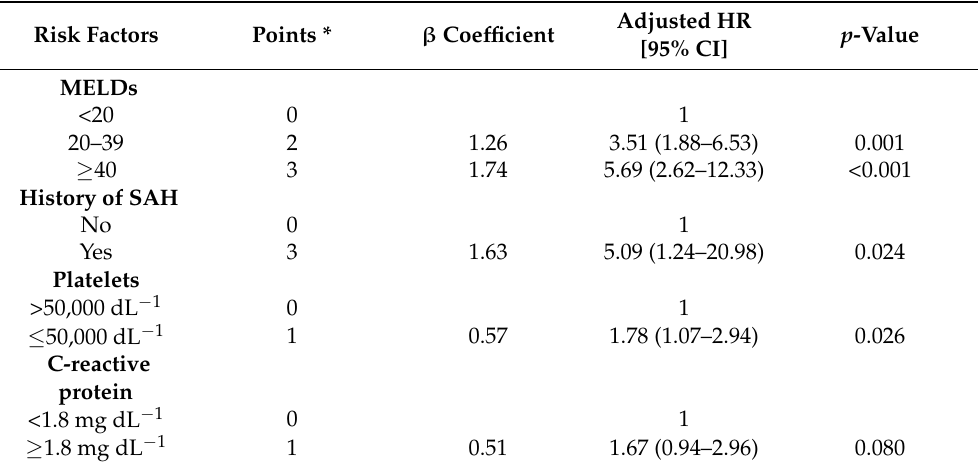
Table 3. Final model with Cox regression analysis of risk factors of 1-year hemorrhagic stroke after liver